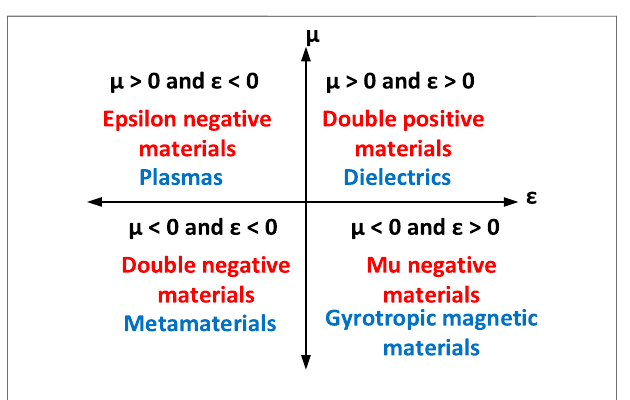
FIGURE 2 | Classi fi cation of materials.